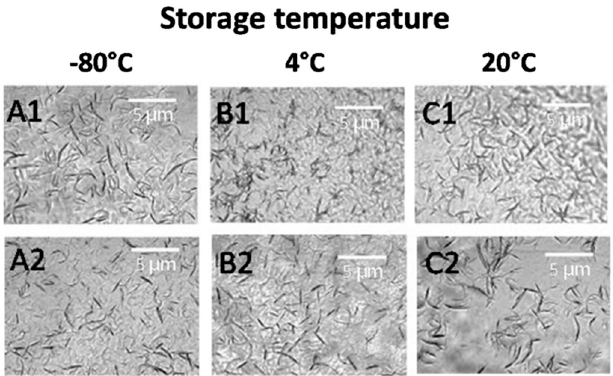
Figure 5. Visible light microscopy images of anti-CD20 crystals obtained through hanging drop vapor diffusion after seven days. ( A1 ) and ( A2 ) show crystals obtained using protein which underwent to one and two cycles of thawing/storage ( − 80 °C, seven days), respectively. ( B1 ) and ( B2 ) are related to crystals obtained using a single cycle of thawing/storage at 4 °C for seven and 14 days, respectively. ( C1 ) and ( C2 ) differ from (B1) and (B2) in storage temperature only (20 °C).